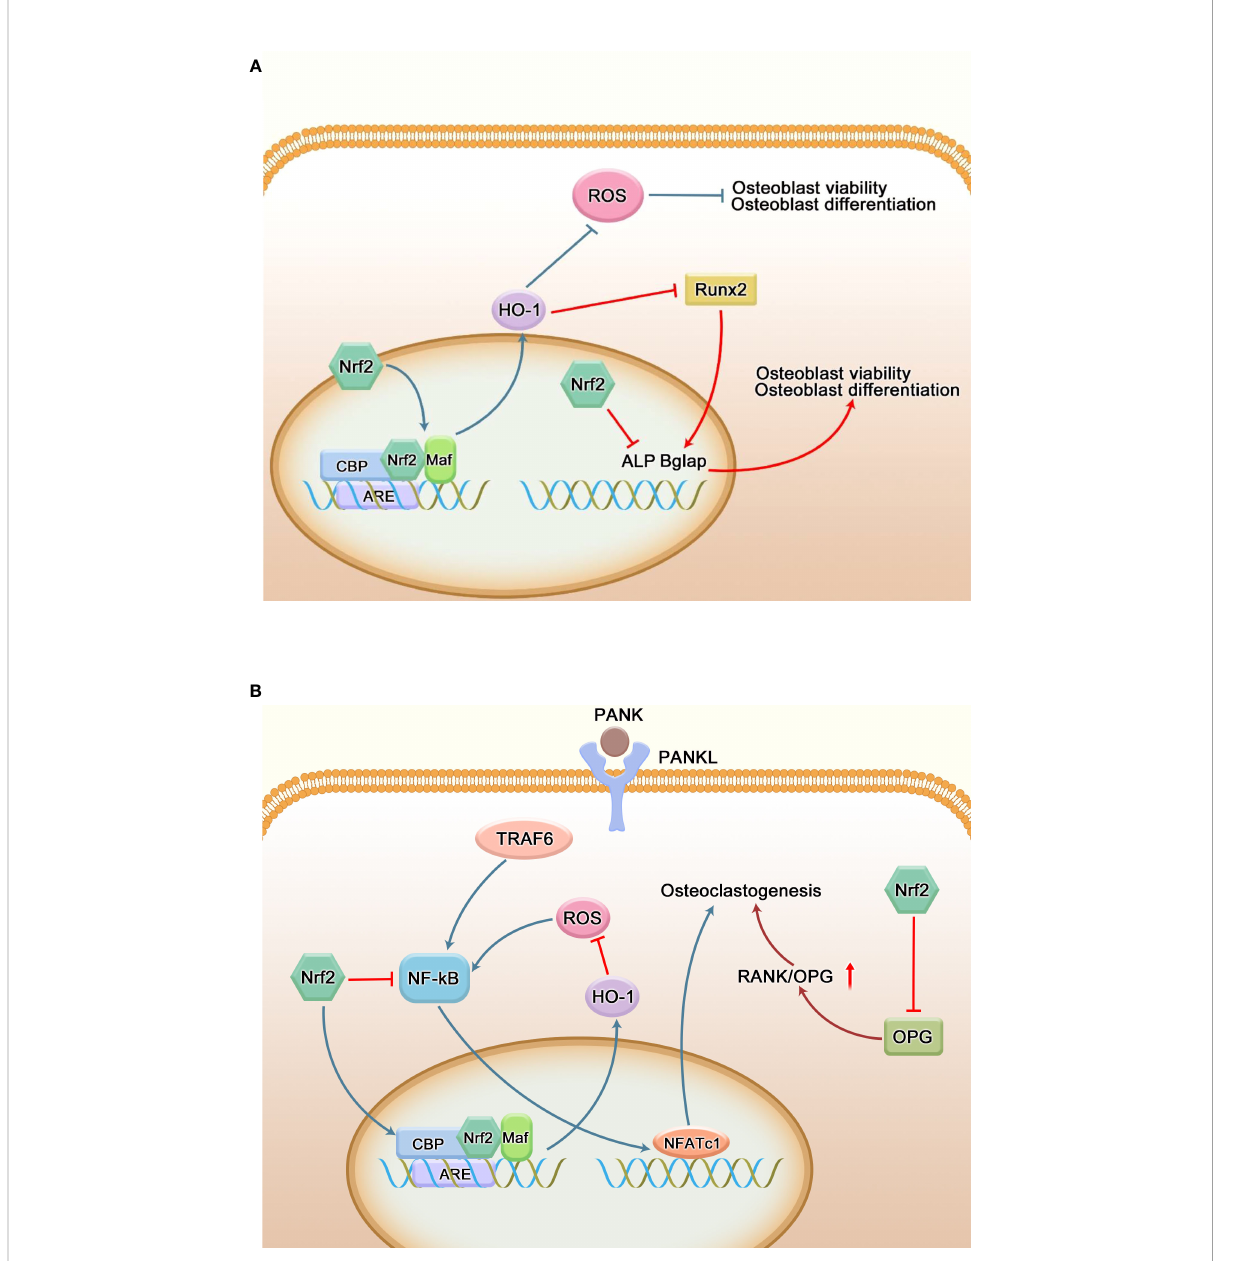
FIGURE 6 Regulation of bone homeostasis by Nrf2. (A) Regulation of osteoblasts by Nrf2. Oxidative stress hinders the proliferation and differentiation of osteoblasts, resulting in osteoblast dysfunction. Nrf2 is able to reduce peroxidation through its antioxidant capacity, thereby reducing osteoblast damage and maintaining its function. Runx2 is a transcription factor necessary for osteoblast differentiation, and overexpression of Nrf2 and its downstream factor (HO-1) interacts with Runx2; it can also directly inhibit the expression of many key genes regulating osteogenic differentiation and mineralization to negatively regulate osteogenic differentiation. (B) Regulation of osteoclasts by Nrf2. RANKL regulates the mature differentiation of osteoclasts by binding to RANK on the surface of osteoclast precursor cells. ROS can directly or indirectly promote the differentiation of osteoclast precursor cells into osteoclasts. The Nrf2/ARE signaling pathway ultimately inhibits the activity of the key osteoclast transcription factor NFATC1 by regulating the production of ROS and the expression level of NF- k B and other related signaling pathways, thereby inhibiting the differentiation of osteoclasts. Meanwhile, Nrf2 can also indirectly promote the formation of osteoclasts by inhibiting the secretion of OPG by osteoblasts and increasing the ratio of